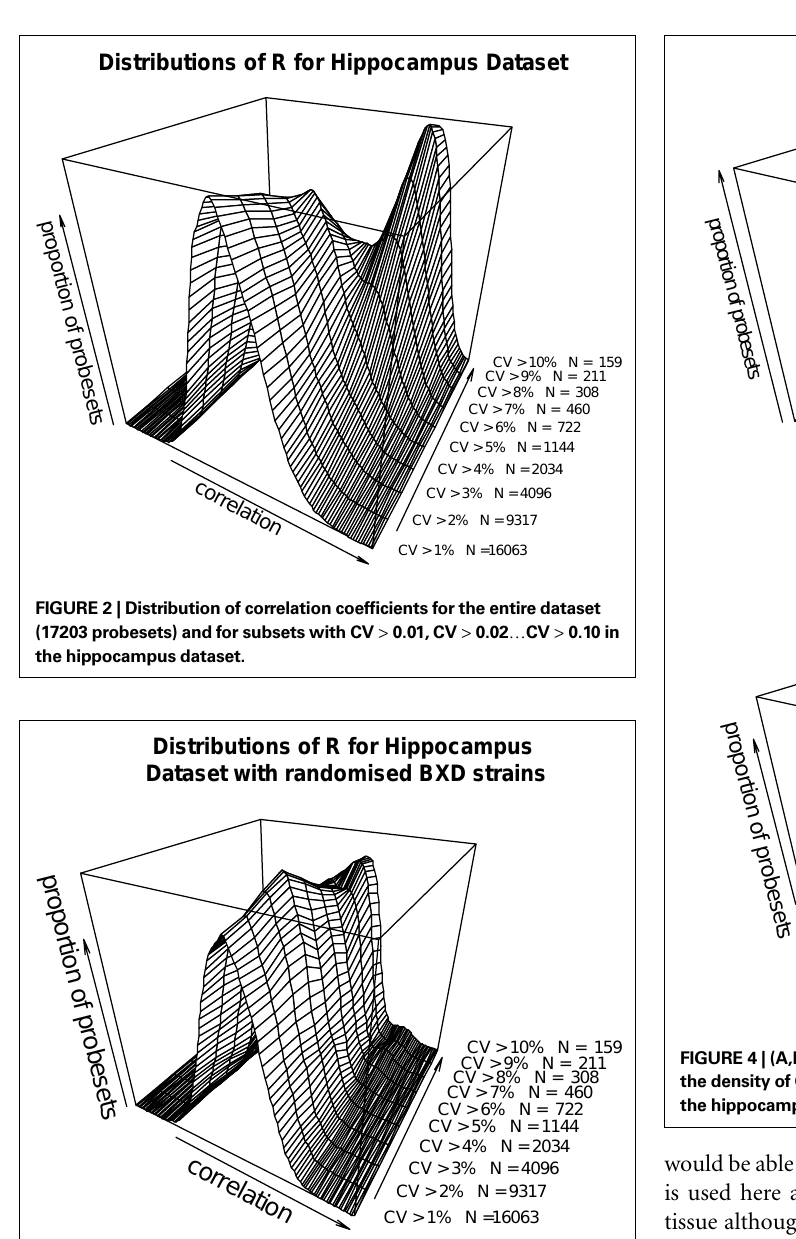
FIGURE 3 | Pearson’s product-moment correlation plotted against the density of CV values for randomised BXD strains for the range of CV > 0.01, CV > 0.02 … CV > 0.10 for the hippocampus dataset.